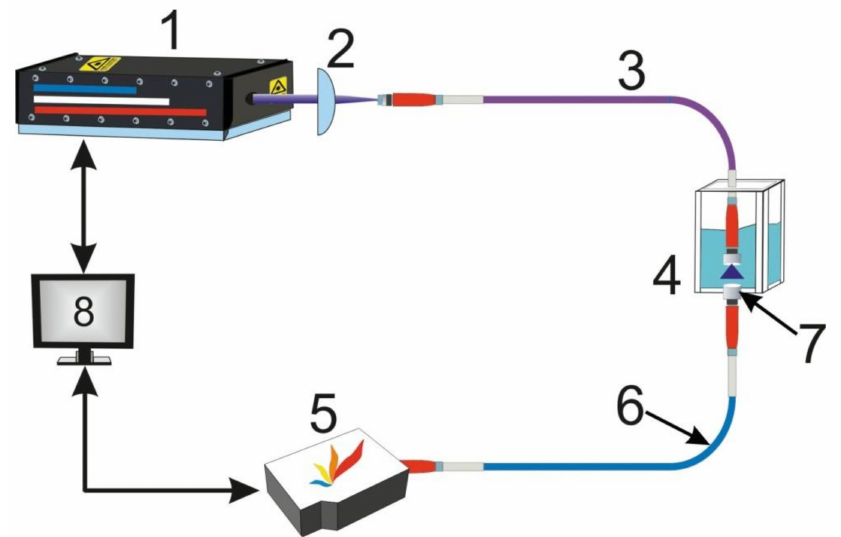
Figure 3. 1—Q-Smart 850 (Quantel, Les Ulis, France)/Tsunami + Spitfire 40f-1k-5W (Spectra-Physics, Santa Clara, CA, USA); 2—lens; 3—quartz fiber; 4—cuvette with solution; 5—Maya 2000 Pro spectrometer (Ocean Optics, Largo, FL, USA); 6—fiber with a core diameter of 600 µ m; 7—collimator 74-UV (Ocean Optics, Largo, FL, USA);